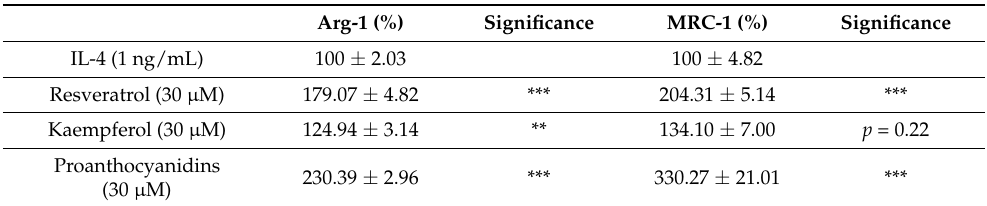
Table 2. The effects of resveratrol, kaempferol, and proanthocyanidins on the expression of Arg-1 and MRC-1 in IL-4-stimulated murine J774 macrophages.